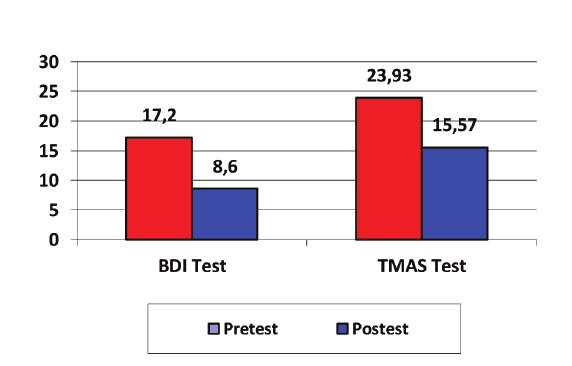
Fig 1. The Development of Anxiety Level Before and After Reality